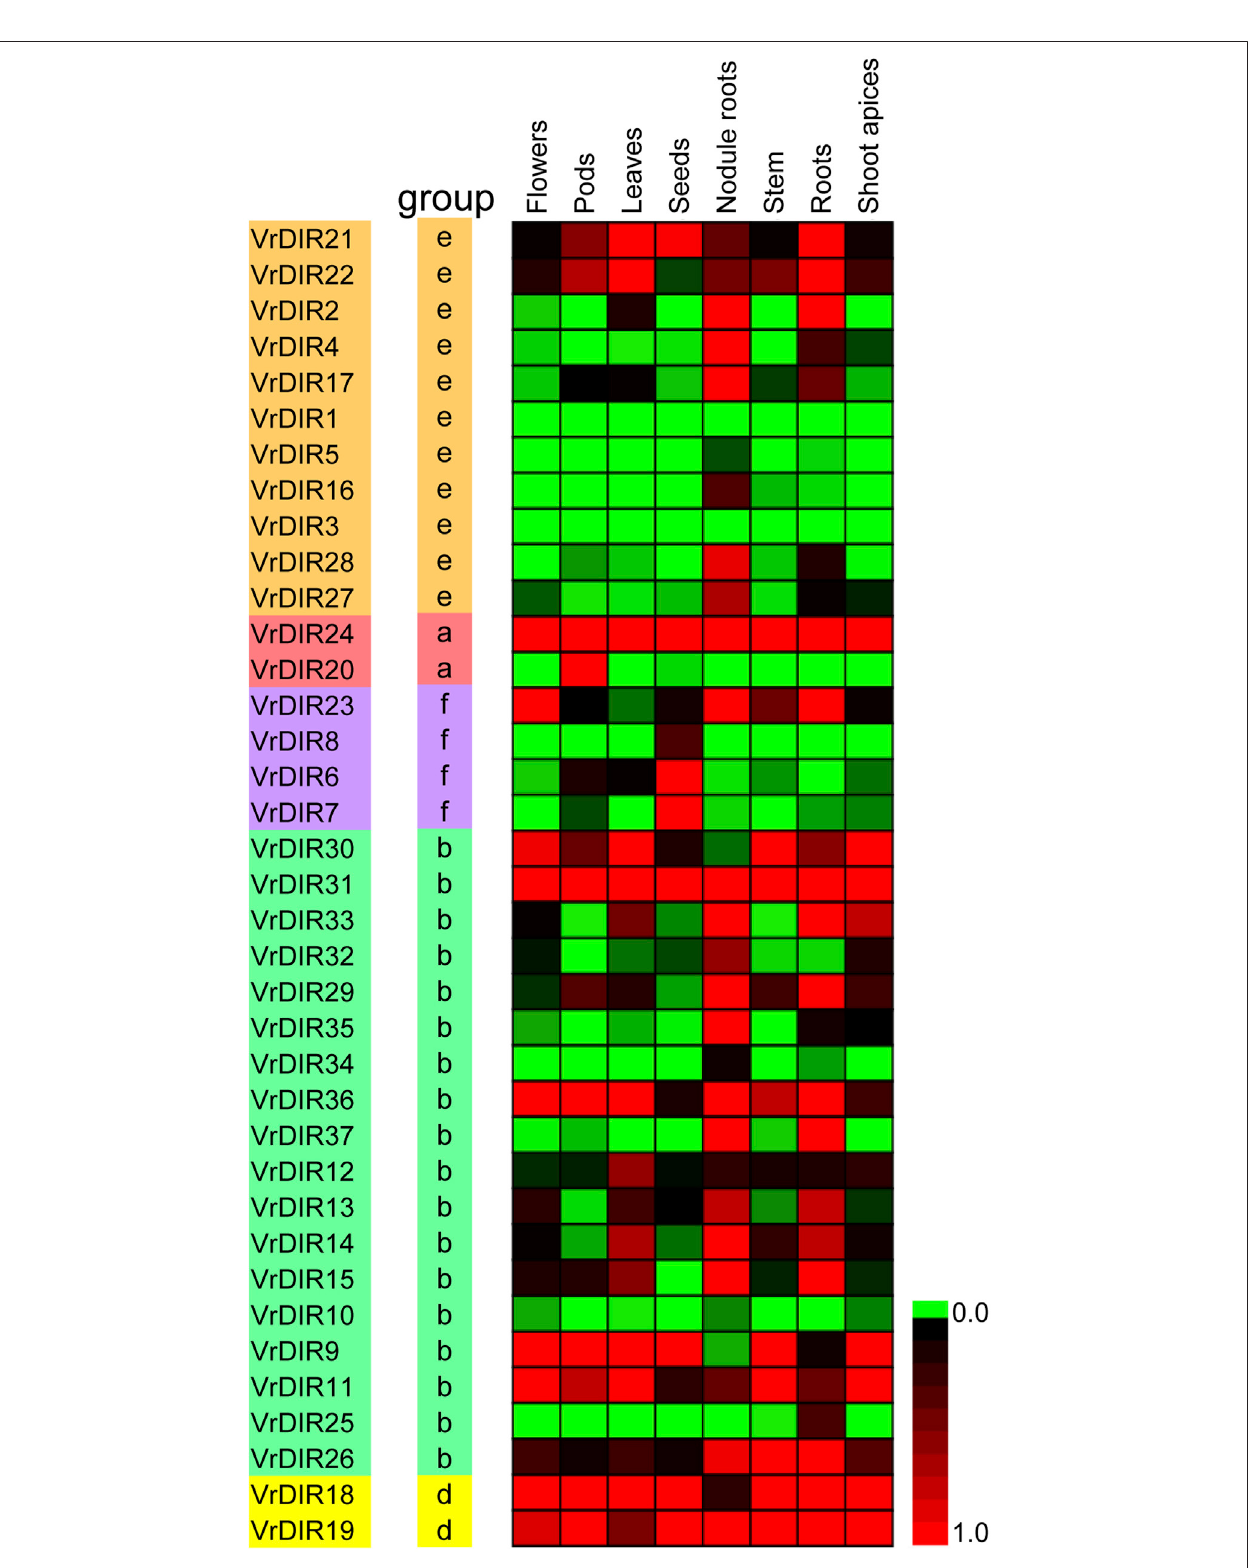
Frontiers in Genetics |